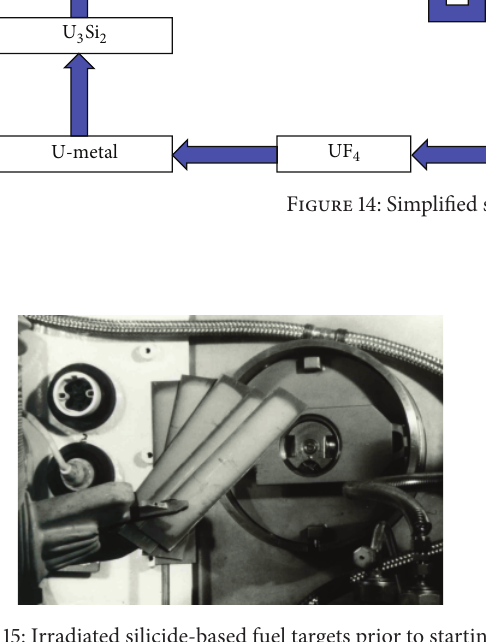
Figure 16: Dissolution cell and the applied hardware devices for process operation at